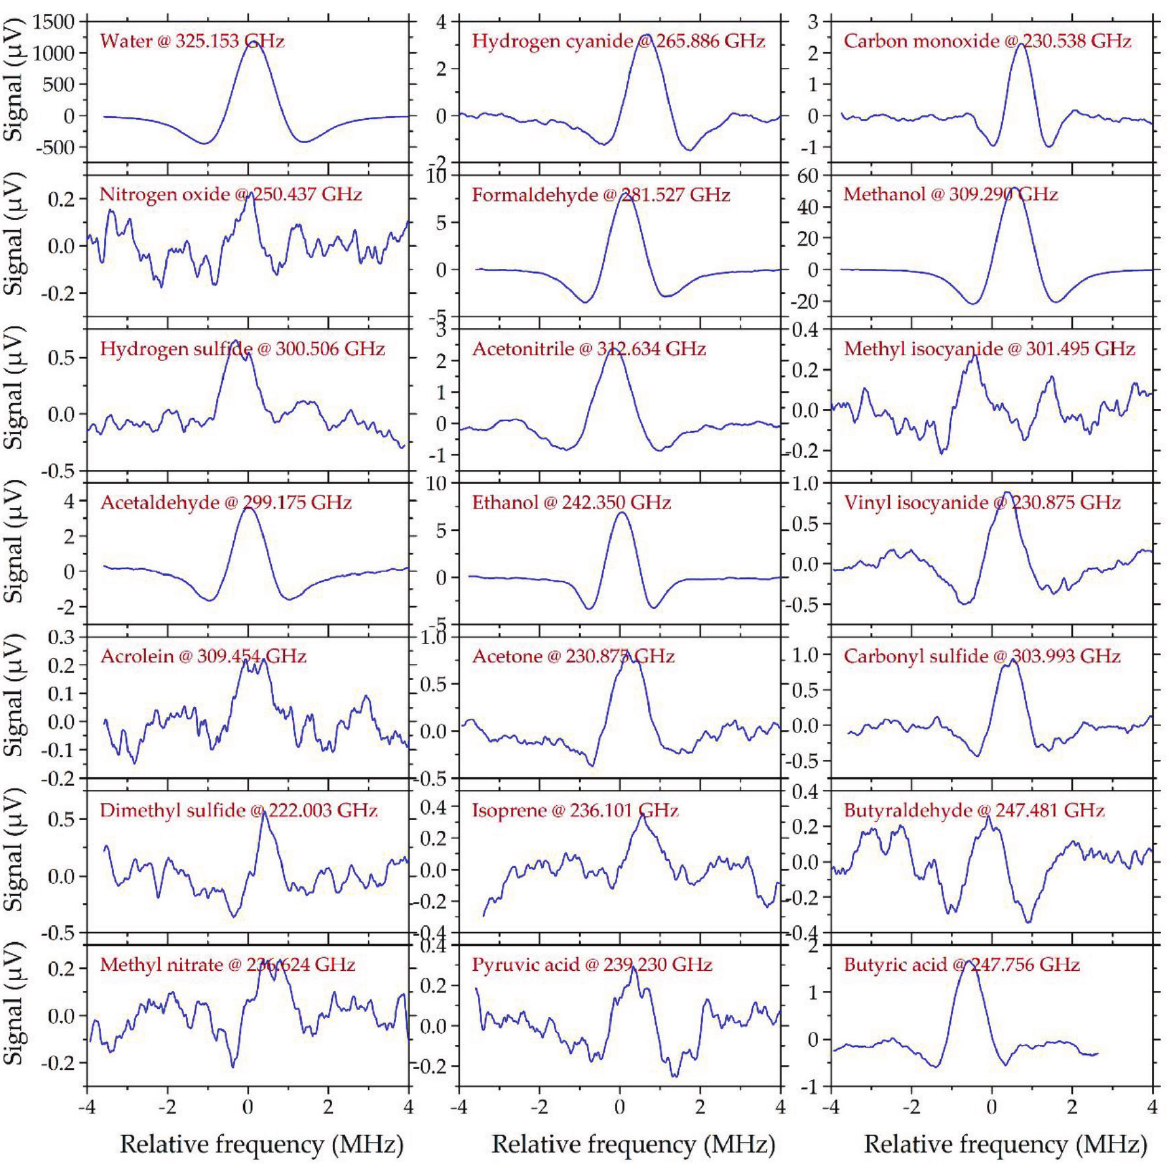
Figure 11: Line scans of the smoker’s sample with the largest signal for each molecular species. Reprinted from Ref.